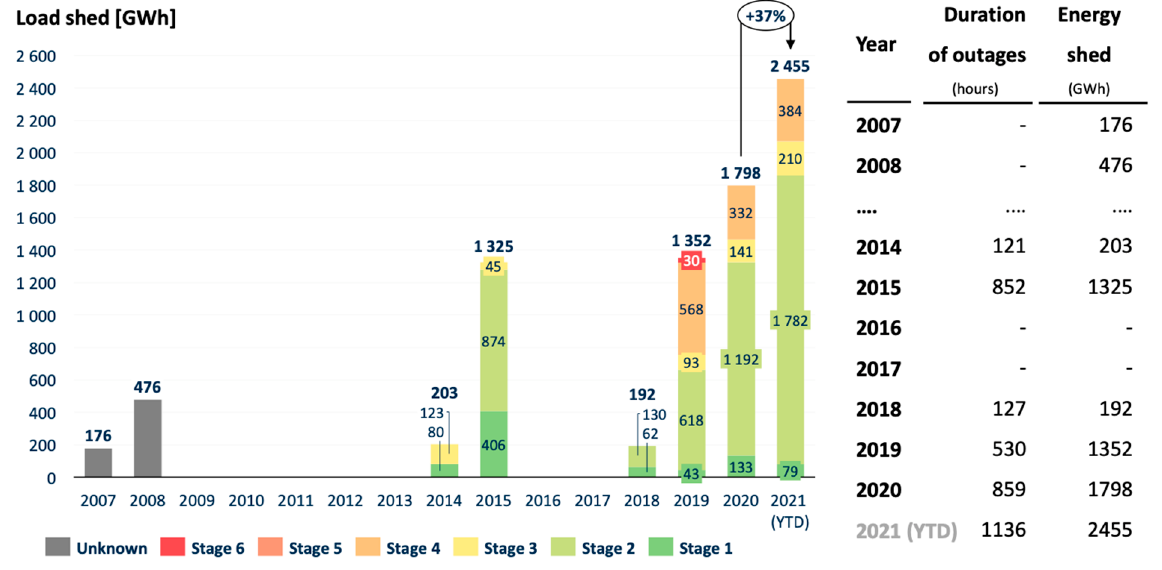
Figure 1. The number of days of load shedding in South Africa.